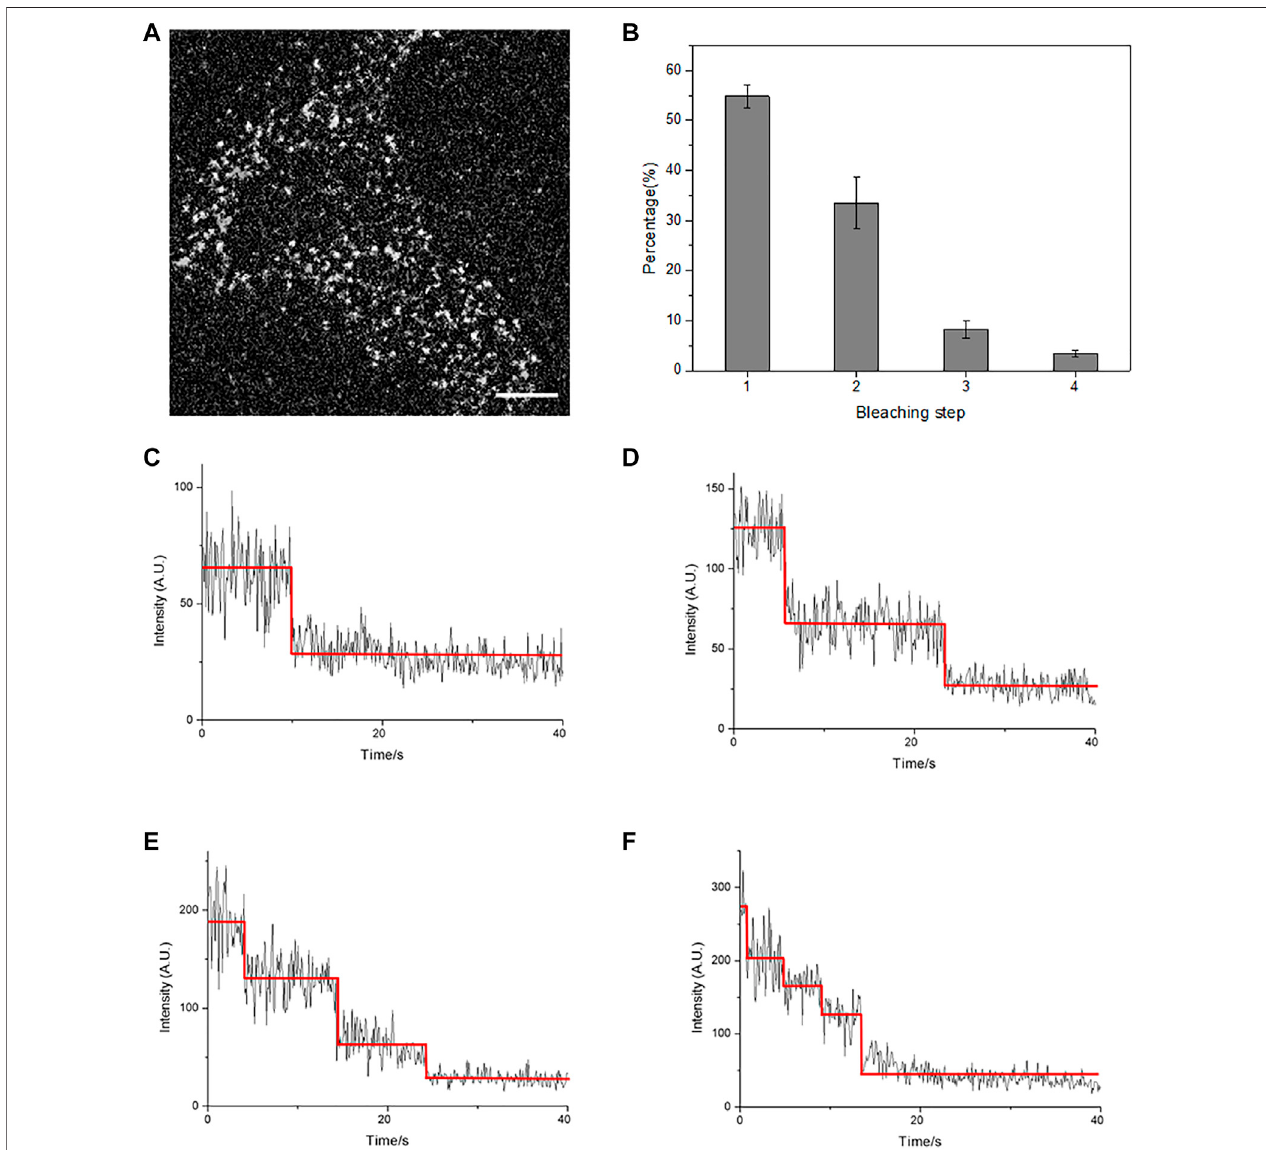
FIGURE 2 | Total internal re fl ection fl uorescence microscopy (TIRFM) imaging revealed a membrane-docked GABAB receptor. (A) A typical single-molecule fl uorescence image of individual receptor molecules on the HEK293 cell membrane in the absence of GABA. Scale bars: 5 μ m. (B) The population of bleaching steps of GABAB receptor, GBR1-EGFP/GBR2, on the cell membrane. (C – F) Four representative time courses of GBR1-EGFP/GBR2 emission showed one-(C), two-step (D) , three-step (E), and four-step (F) bleaching, respectively. The red lines denote the automatically estimated bleaching steps. The results in (B) were calculated from 20 cells with more than 2000 single fl uorescent